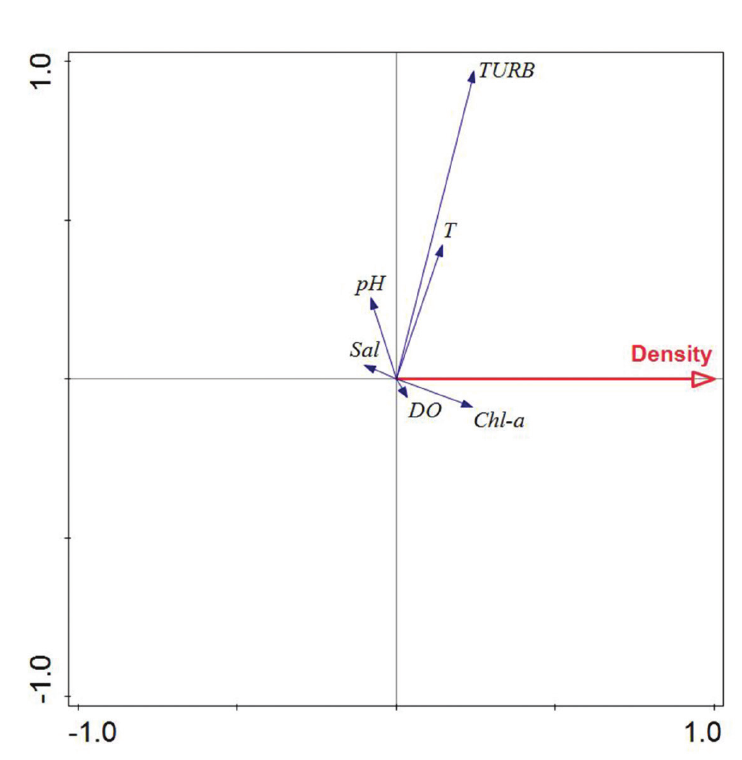
Figure 5. Analysis of correlation between environmental factors and mean density of S. carinata (T: temperature; DO: dissolved oxygen; Sal: salinity; TURB: turbidity; Chl-a: